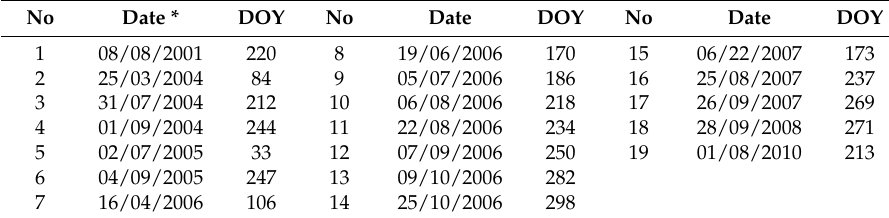
Table 2. Landsat 5 TM (Path: 122, Row: 64) imageries used to validate surface water areas derived